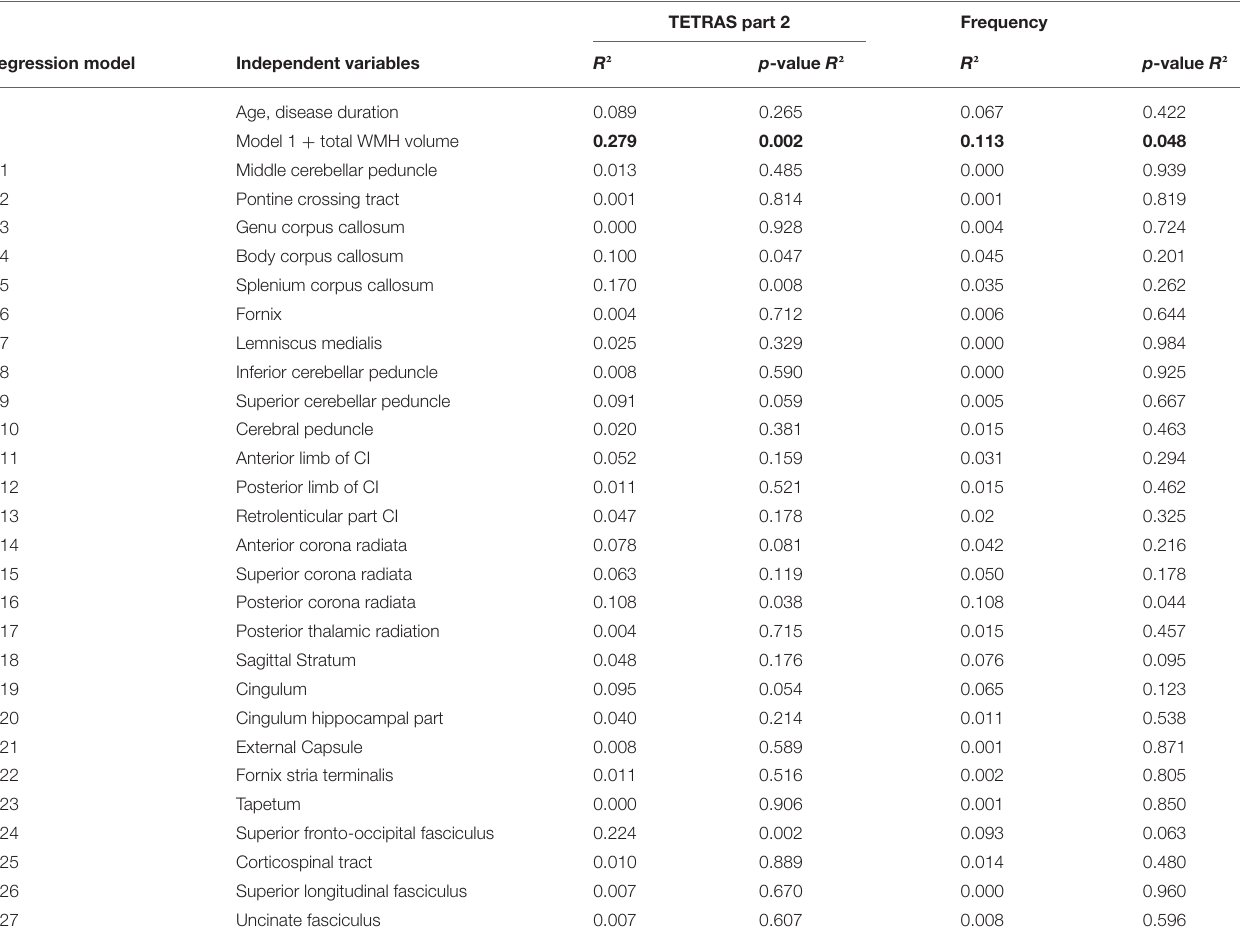
TABLE 2 | Assumption-free ROI-based analysis to identify strategic white matter tracts that are associated with tremor severity (TETRAS part 2) and accelerometric frequency based on the JHU labels atlas.